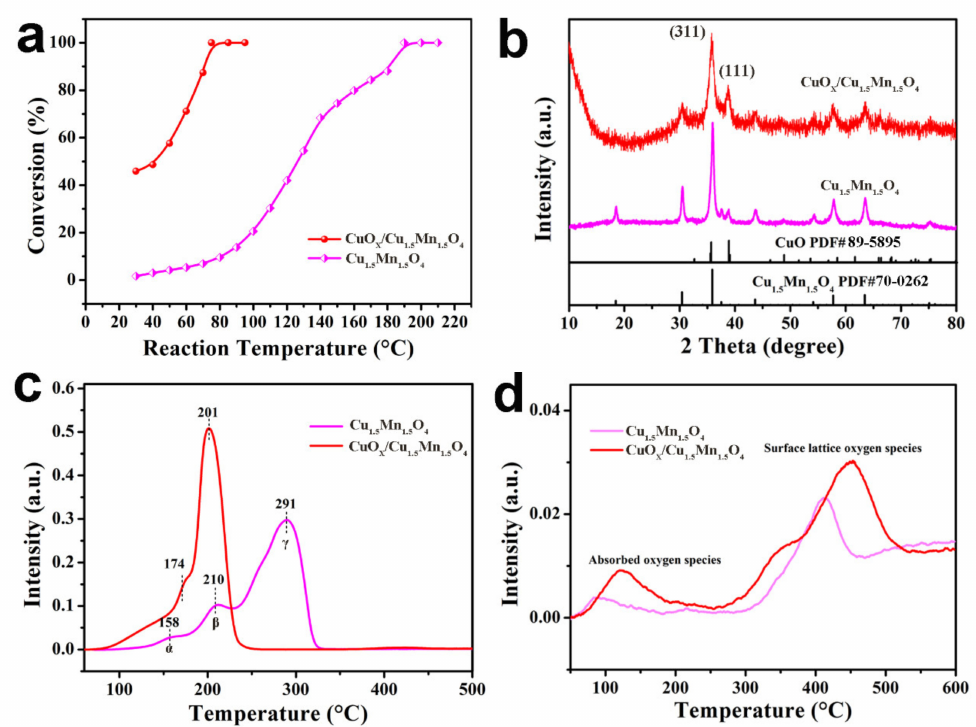
Figure 7. ( a ) The CO conversion performances; ( b ) the powder XRD patterns; ( c ) H 2 -TPR; ( d ) O 2 -TPD profiles of Cu 1.5 Mn 1.5 O 4 and CuO x /Cu 1.5 Mn 1.5 O 4 ,